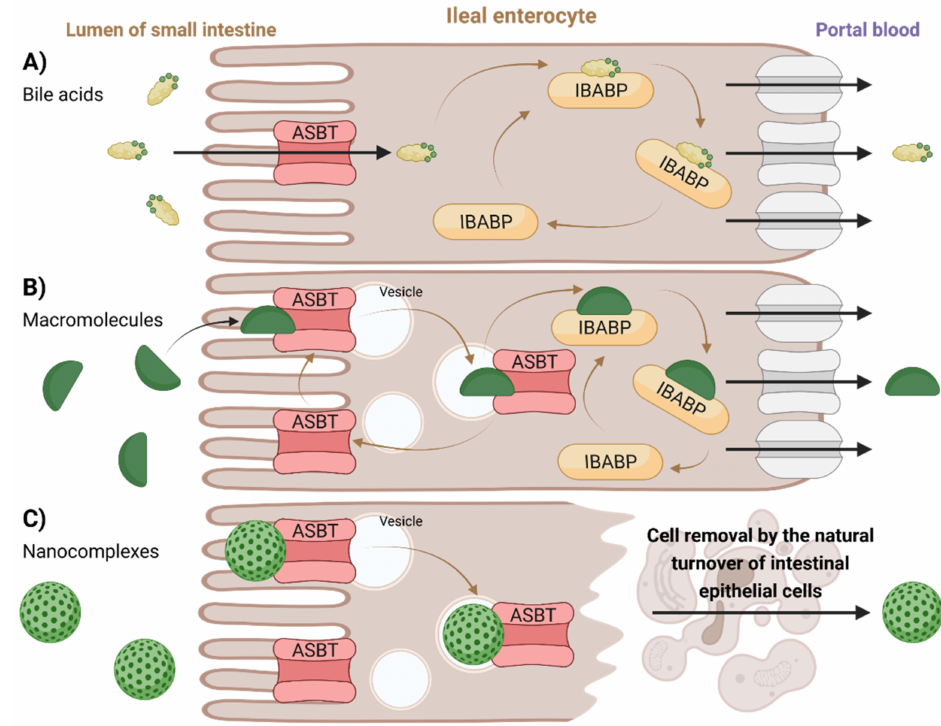
Figure 7. Proposed methods of intracellular transport in the ileal enterocytes. In general, BAs or BA-derived carriers are initially absorbed into the enterocytes via the ASBT protein. ( A ) Transport of BAs and small BA-conjugated drugs continues using IBABP, and later, the molecule is released into portal blood by various transporters. ( B ) BA-containing macromolecule forms a complex with ASBT protein, which is taken up in vesicles. ASBT protein is then recycled back into the membrane, while the macromolecule is released into the bloodstream by various transporters. ( C ) BA-containing nanocomplex is contained in vesicles upon ASBT-mediated uptake. The nanoparticle is then released into the bloodstream by the natural turnover process of epithelial cells. Created with